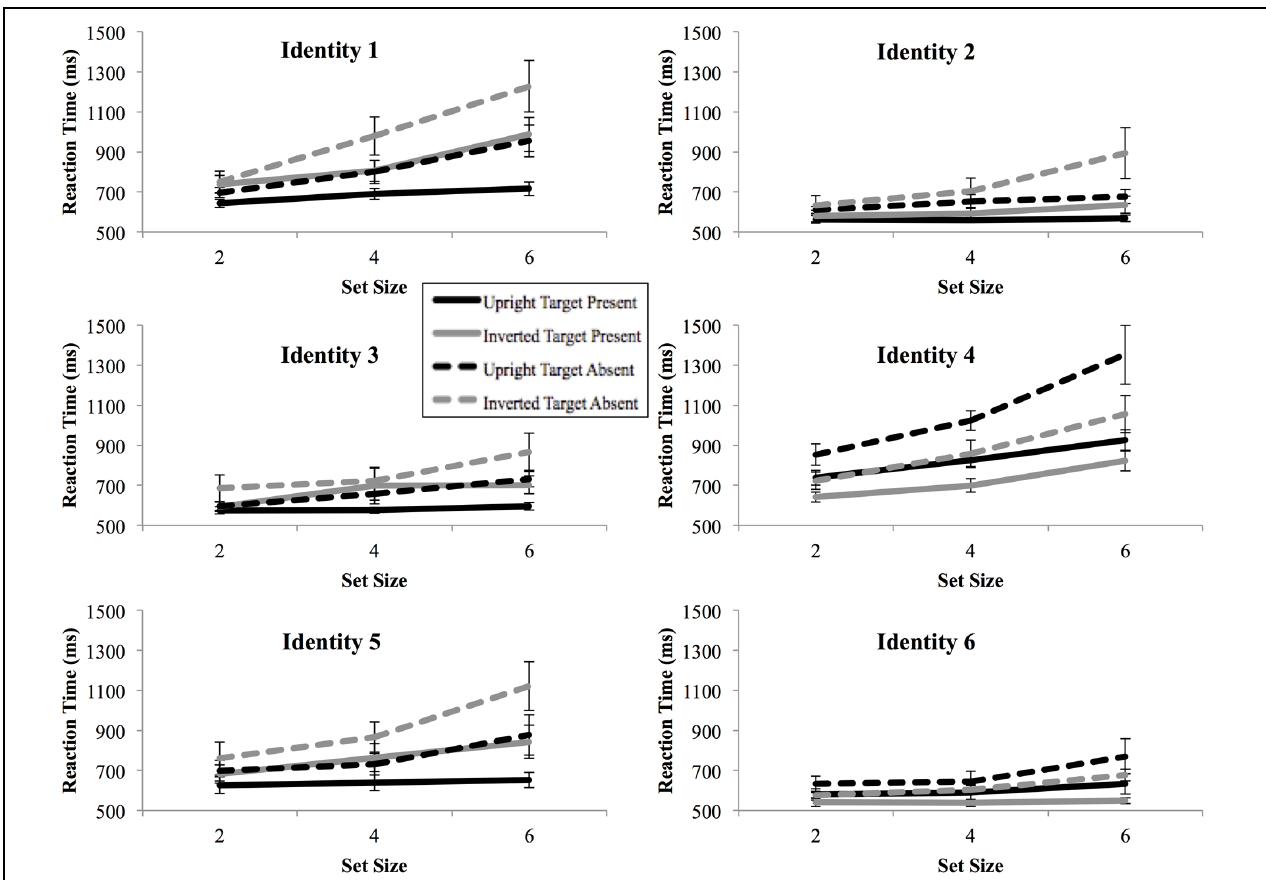
FIGURE 3 | Mean reaction times as a function of search array set size for each target image in Experiment 2. Slightly different trends for the search reaction times are observed for different targets. Black lines, upright condition; gray lines, inverted conditions; Solid lines, target-present; dash lines, target-absent. Error bars represent ± 1